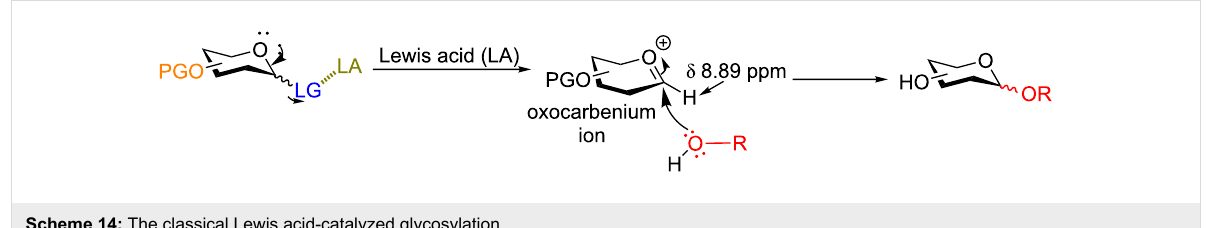
the chemical stability of the glycosyl cation [53]. The stereo- chemical outcome of the reaction is generally dictated either by neighboring-group participation of position 2 on the ring or by the anomeric effect when neighboring group participation is not possible